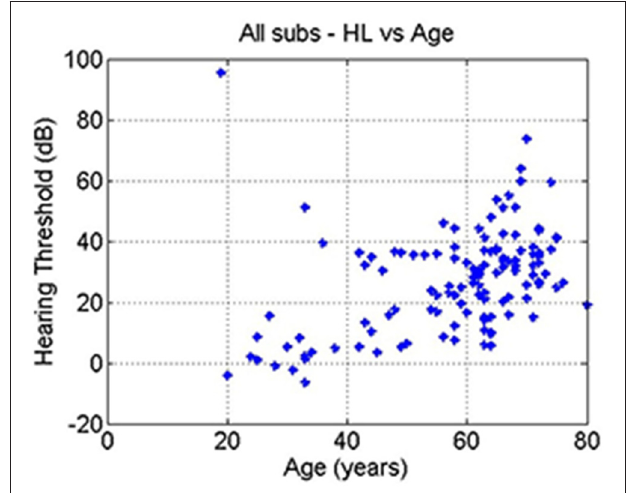
FIGURE 4 | The age of each subject plotted against their hearing